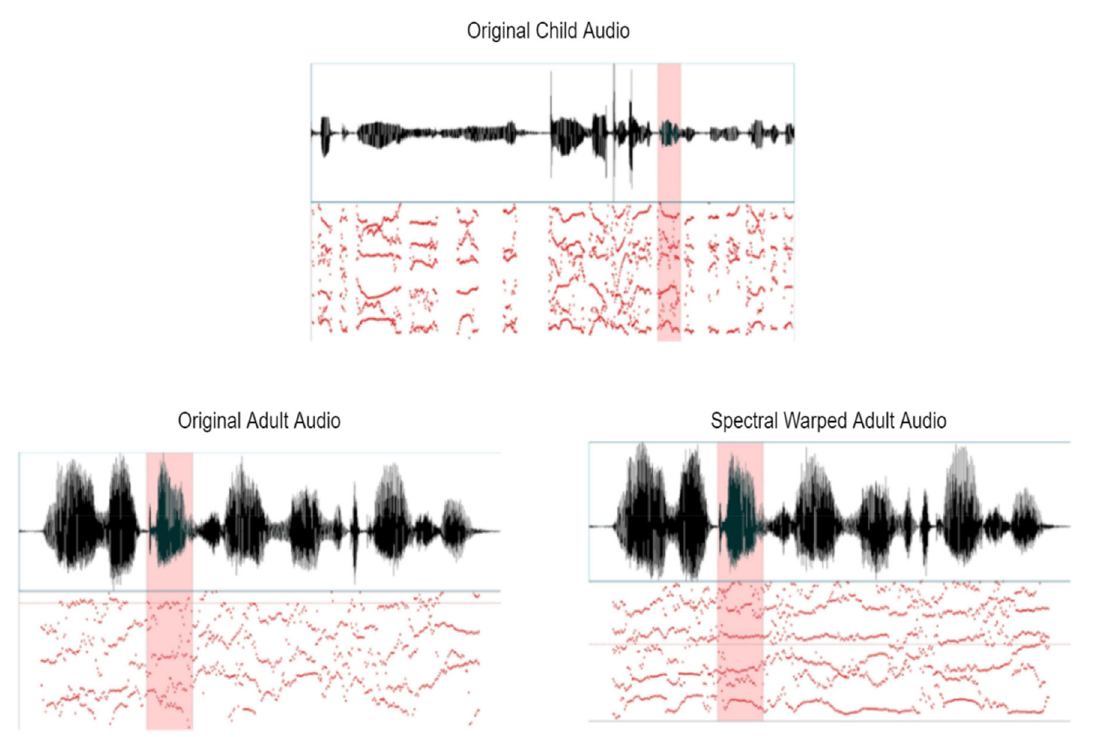
Fig. 3 Comparative illustration of original children and spectral warped adult audio